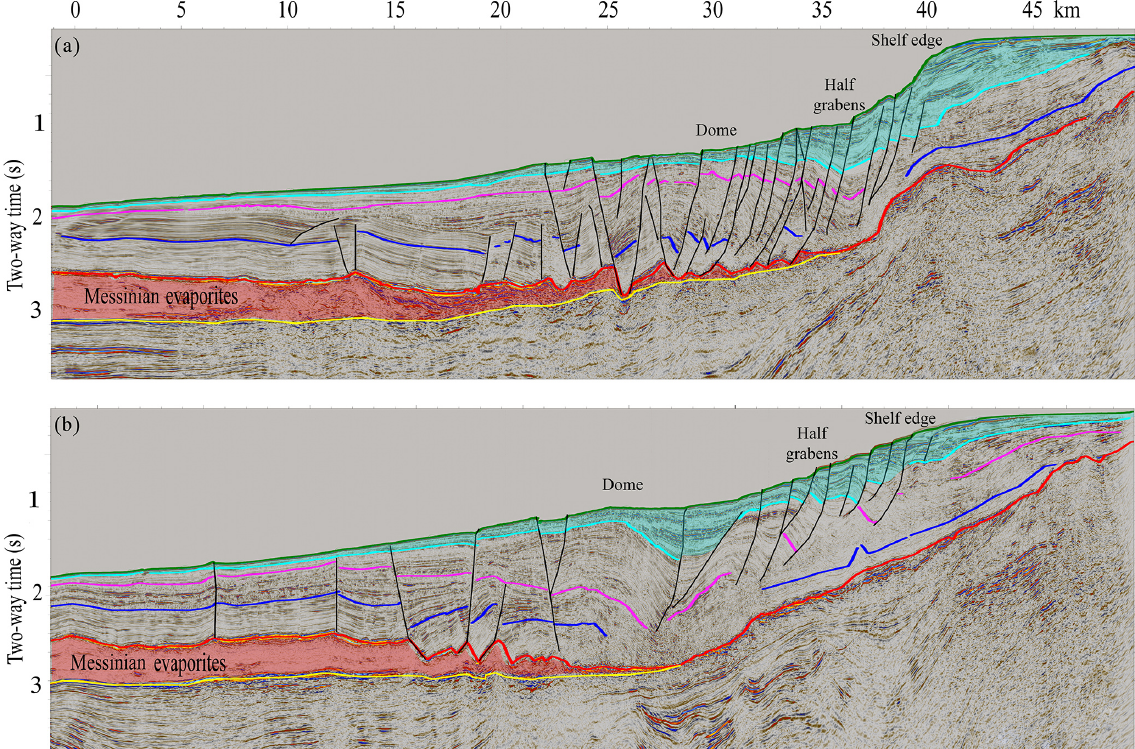
Figure 5. Cross section (a) north and (b) south of the Dor disturbance (seismic location in Fig. 4a). Normal faults in black lines. Seismic reflectors as in Fig.